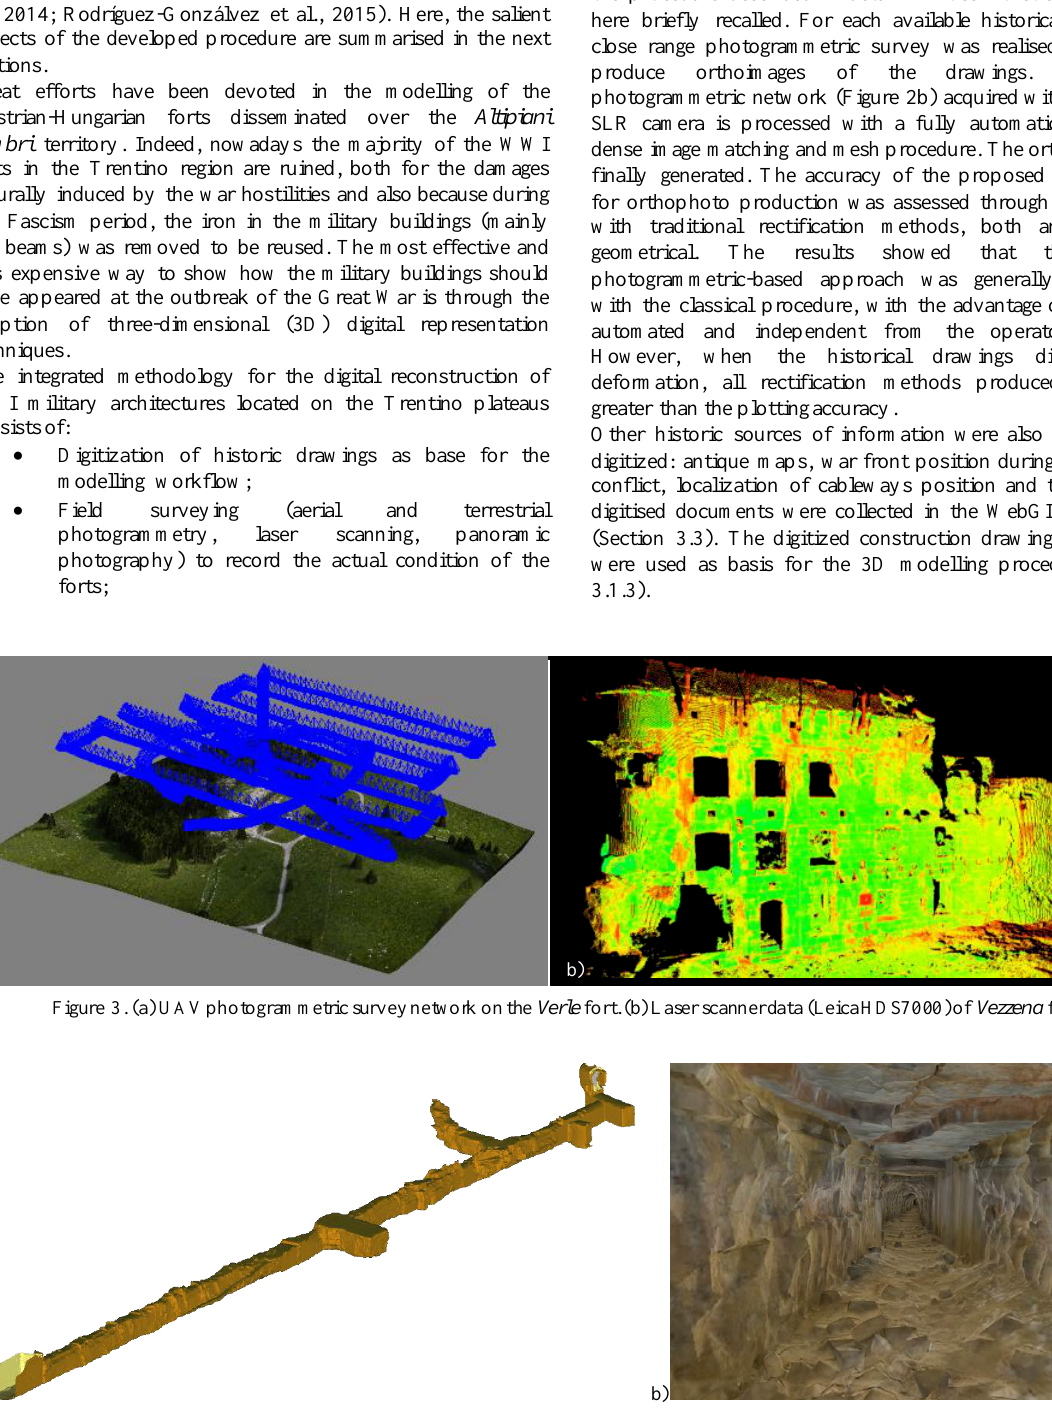
Figure 4. The final mesh model (a) and view of the texturized interior (b) of the 110 m long underground